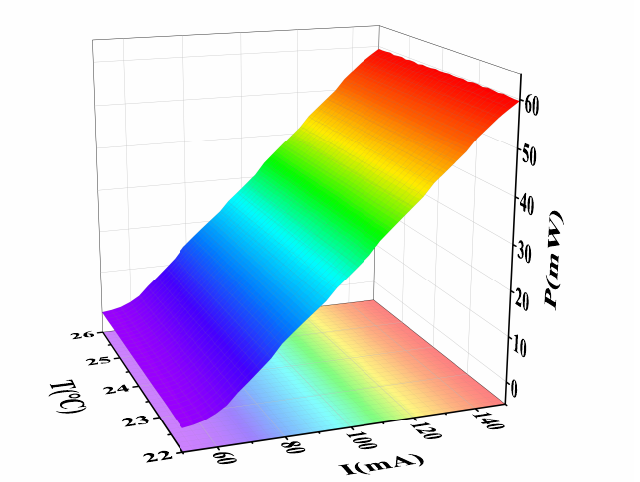
Figure 5. Power prediction of the GPR − P